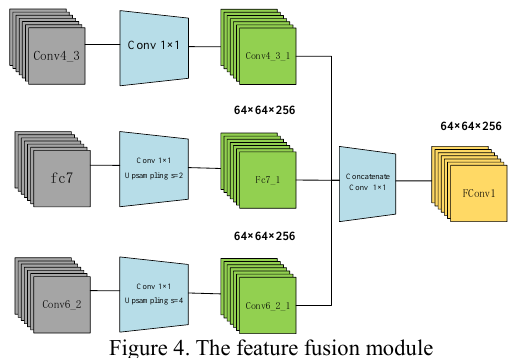
Figure 4. The feature fusion module